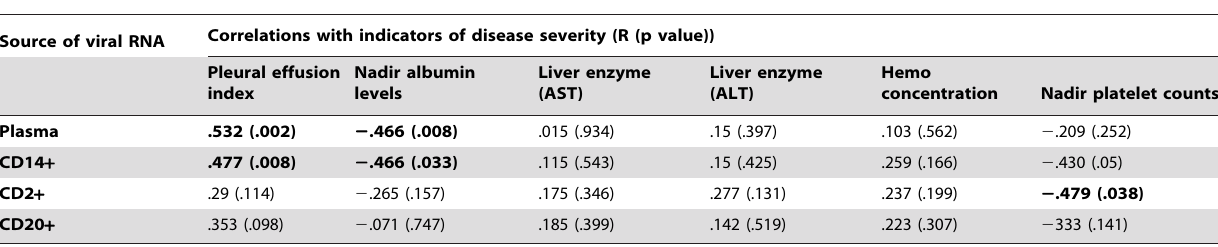
Table 2. Univariate correlations between indicators of disease severity and viral RNA levels in plasma and cell fractions collected on fever